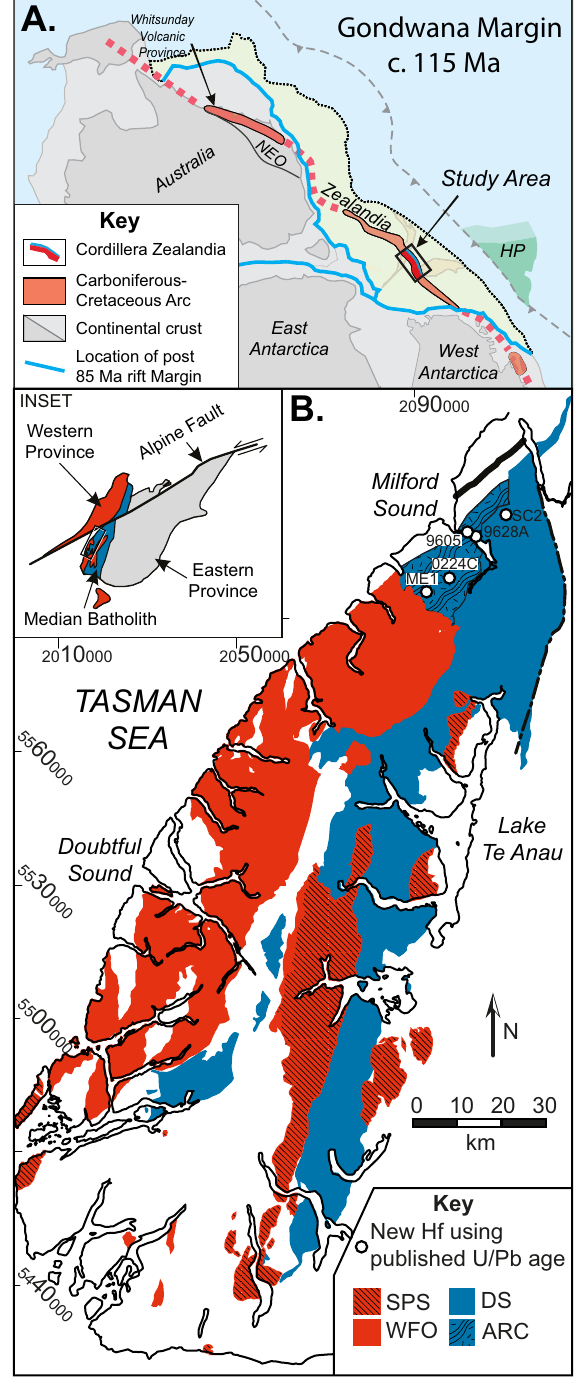
Figure 1. ( A ) Tectonic reconstruction of the Palaeo-Pacific Gondwana Margin at c. 115 Ma (modified from Mortimer, 73 ). The Whitsunday Volcanic Province has been viewed as a correlative to the Cretaceous Flare up in New Zealand 74 , however some features have been interpreted as a large igneous province 75 . NEO = New England Orogen. The yellow shaded region represents the Zealandia orogenic belt prior to rifting and fragmentation at 85 Ma. HP = Hikurangi Plateau (approximate location). ( B ) Geological map of New Zealand showing main plutonic suites; WFO (Western Fiordland Orthogneiss), SPS (Separation Point Suite) and DS (Darran Suite). The ARC (Arthur River Complex) is comprised of an older Carboniferous magmatic component and, and a younger Jurassic to Cretaceous magmatic component that overlaps with the Darren Suite in age 25, 53, 54, 76 . This study includes Cretaceous ARC samples that have not been formally assigned to a suite however are considered a correlative of the Darren Suite based on age and geochemistry 25, 53, 54 . A further sample defined as Darren Suite is also included. Modified from Turnbull et al. 20 , available under CC BY 4.0 license (http://creativecommons.org/licenses/by/4.0/). Inset: Palinspastic reconstruction of Median Batholith prior to dextral displacement along Alpine